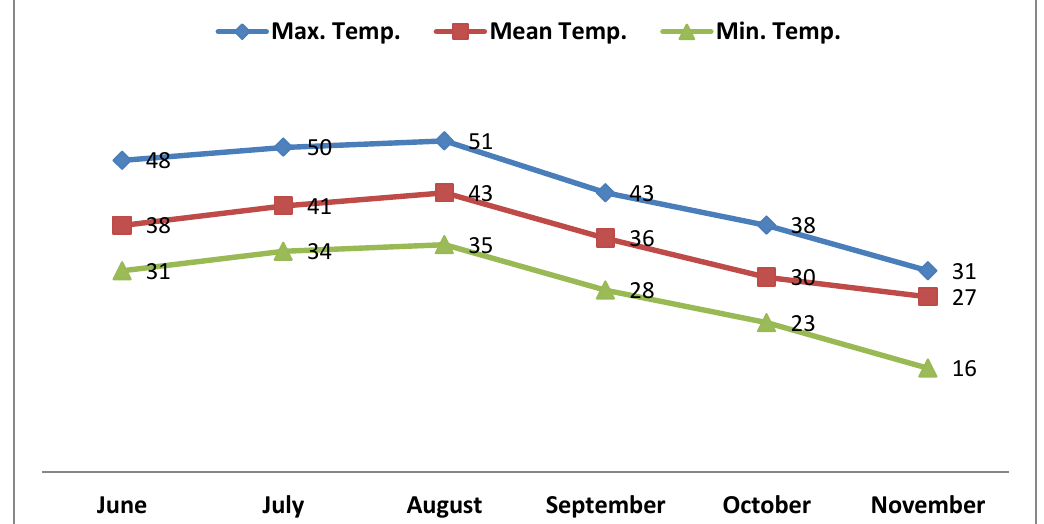
Figure (1): Averages of temperature (Cᵒ) along months involved in the study from mid- June/2011 to mid-November/2011 (13). Measurement of some genital organs dimensions of male reproductive system: Three males were selected randomly to slaughter each month along the study period to obtain the genital organs (testis, seminal vesicle gland and bulbourethral gland) and measure weights and some dimensions such as length and diameter, the parameters were taken from only right sided genital organs by using caliper